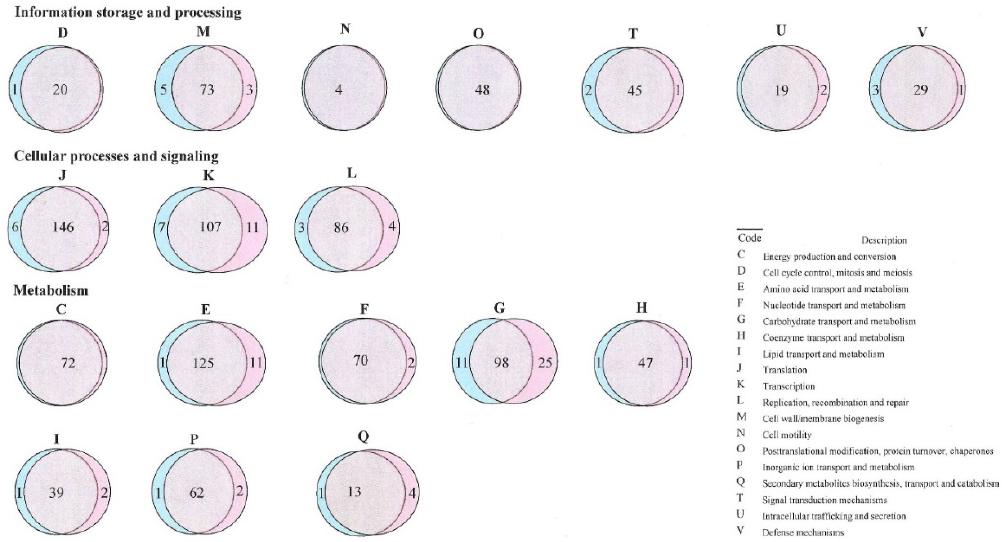
Figure 2. Venn diagram showing the Clusters of Orthologous Groups (COG) function categories of 18 Enterococcus cecorum clinical (PS; shown in pink) and non-clinical (ARS; shown in teal) isolates from chicken.